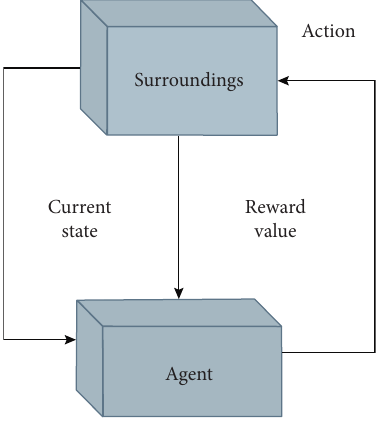
Figure 1: Markov decision